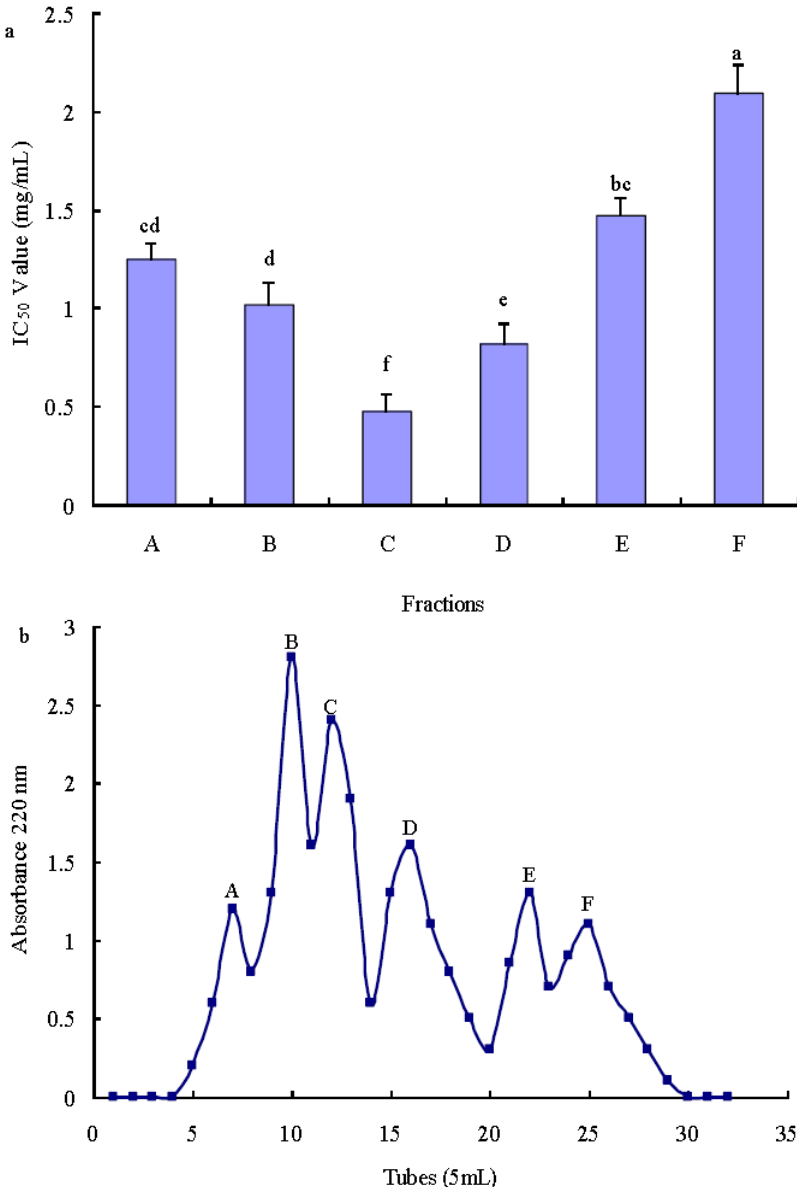
Figure 2. TFPH1 was separated by SP Sephadex C-25 gel chromatography ( a ), and the IC value (mg/mL) of each fraction was measured by hydroxyl radical scavenging activity ( b ). Different letters indicate significant differences ( p <